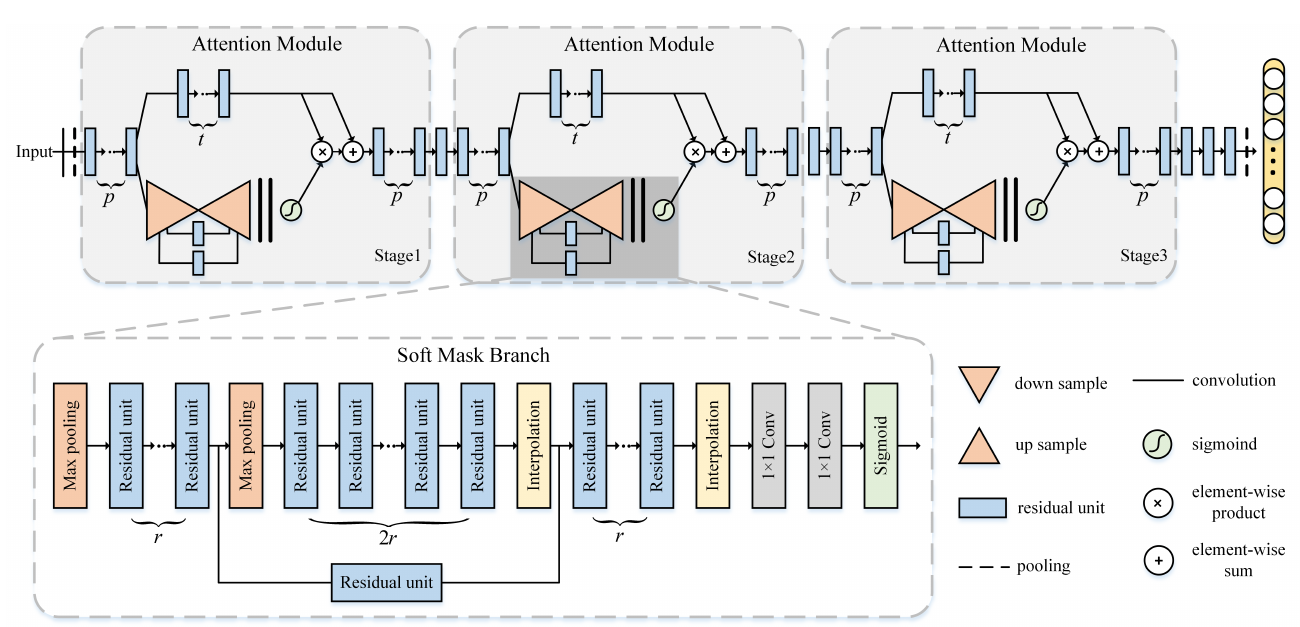
Figure 22. The architecture of Residual Attention Network. There are three hyper-parameters p , t , r . p is the number of pre-processing Residual Units before splitting into trunk branch and mask branch. t denotes the number of Residual Units in trunk branch. r denotes the number of Residual Units between adjacent pooling layer in the mask branch. Ref. [134] set the hyperparameter to p = 1, t = 2, r = 1.